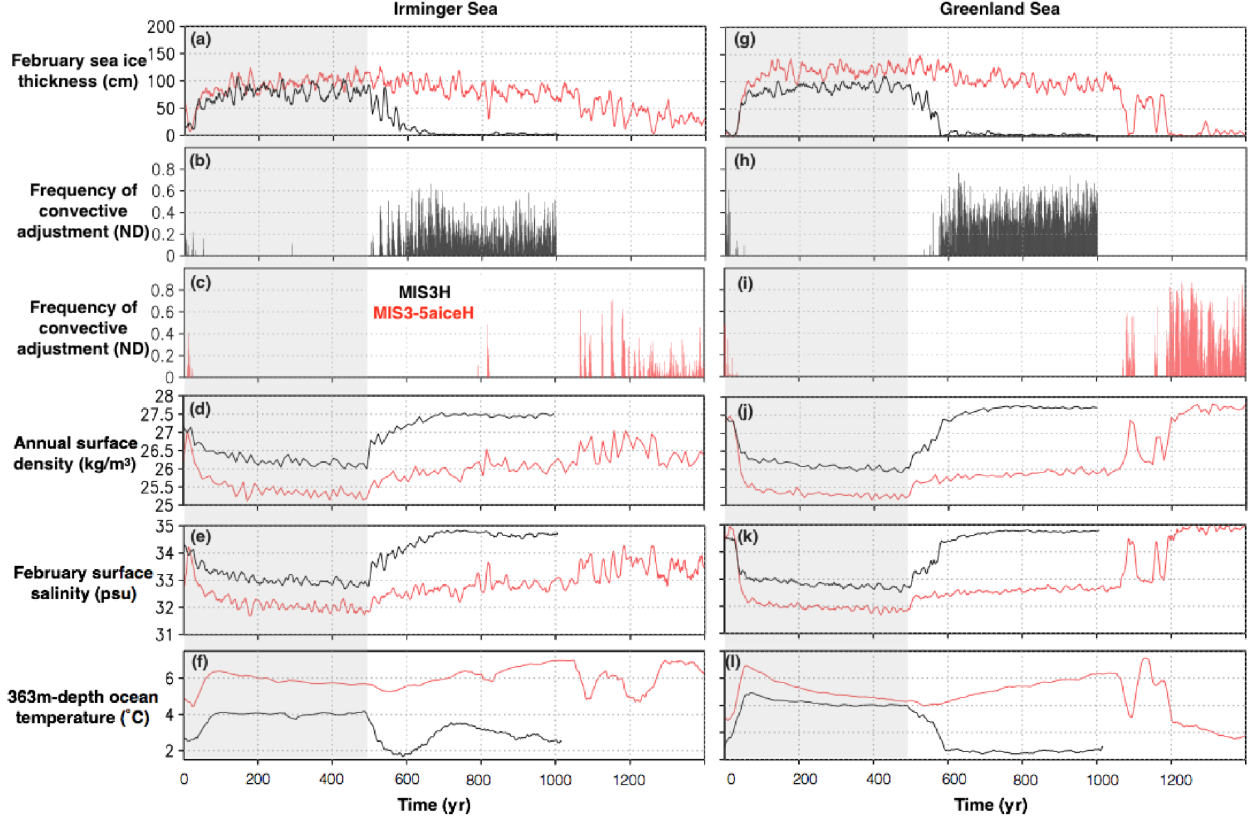
Figure 8. Temporal evolution of oceanic variables in the Irminger Sea (55–63 ◦ N, 35–25 ◦ W; left) and Greenland Sea (65–70 ◦ N, 1 ◦ W– 5 ◦ E; right) for MIS3H (black) and MIS3–5aiceH (red). (a, g) February sea ice thickness (cm). (b, h) Annual average frequency of convective adjustment of MIS3H. (c, i) Same as panels (b) and (h) but for MIS3–5aiceH. (d, j) Annual mean surface density (kgm − 3 ). (e, k) February surface salinity (psu) and (f, l) annual mean subsurface ocean temperature ( ◦ C). Except for panels (b) , (c) , (h) and (i) , 11-year running means are shown. Freshwater flux of 0.1Sv is applied during years 0 to 500 (gray-shaded